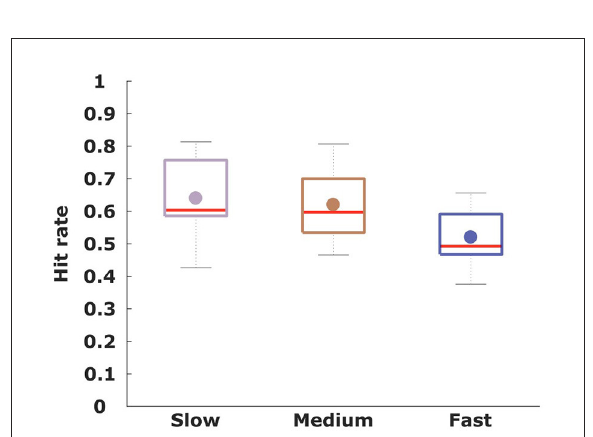
FIGURE3 For every condition the hit-rate on the y-axis is averaged across all participants ( n = 16), indicating how often subjects received positive feedback about their selected stimulus